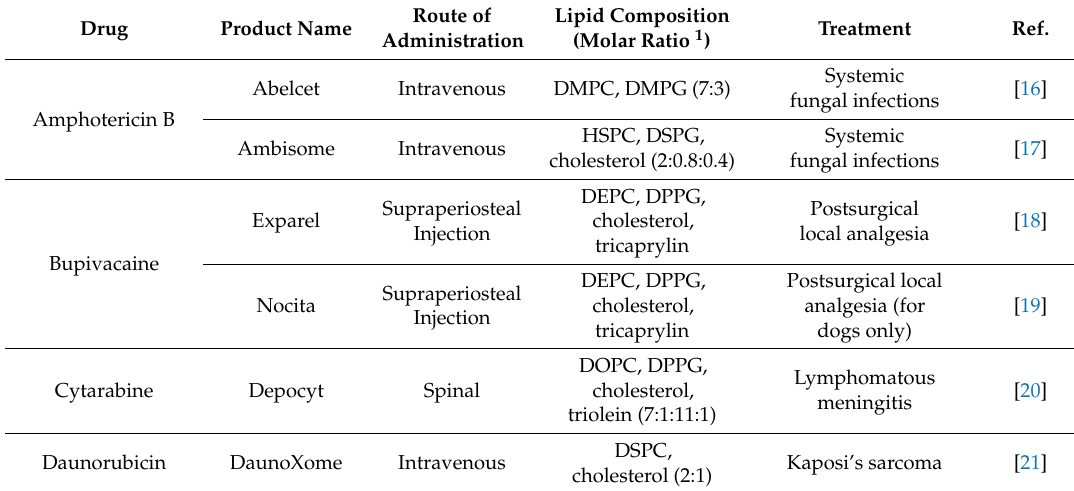
Table 1. List of liposomal drug products for injection clinically approved by European Medicines Agency (EMA) and Food and Drug Administration